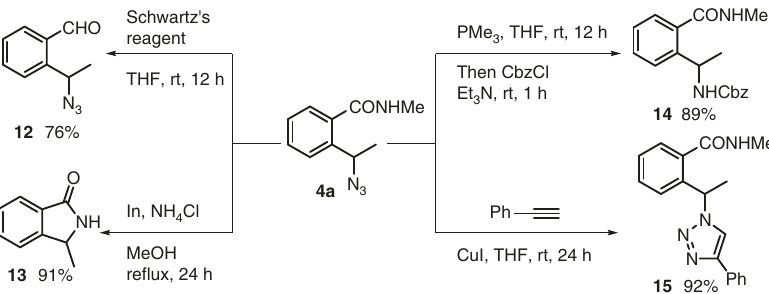
Fig. 6 Transformation of azido amide 4a . Schwartz ’ s reagent = bis(cyclopentadienyl)zirconium(IV) chloride hydride, CbzCl = benzyl